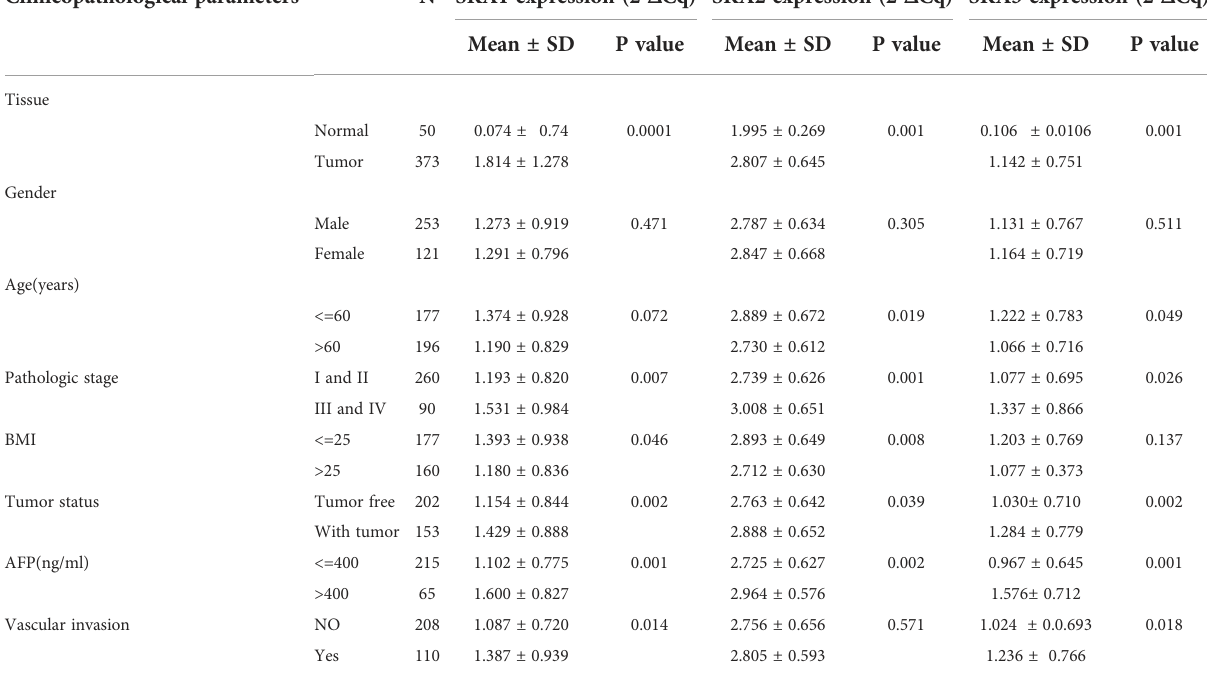
TABLE 2 The relationships between SKA1/2/3 with clinicopathological parameters in HCC patients. Clinicopathological